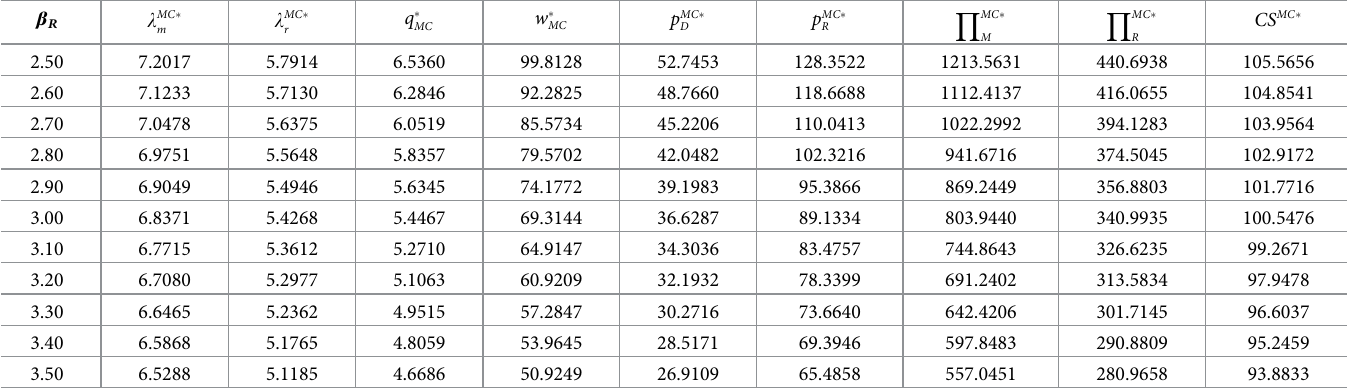
Table 4. In the mixed channel scenario ( ε = 2.5).